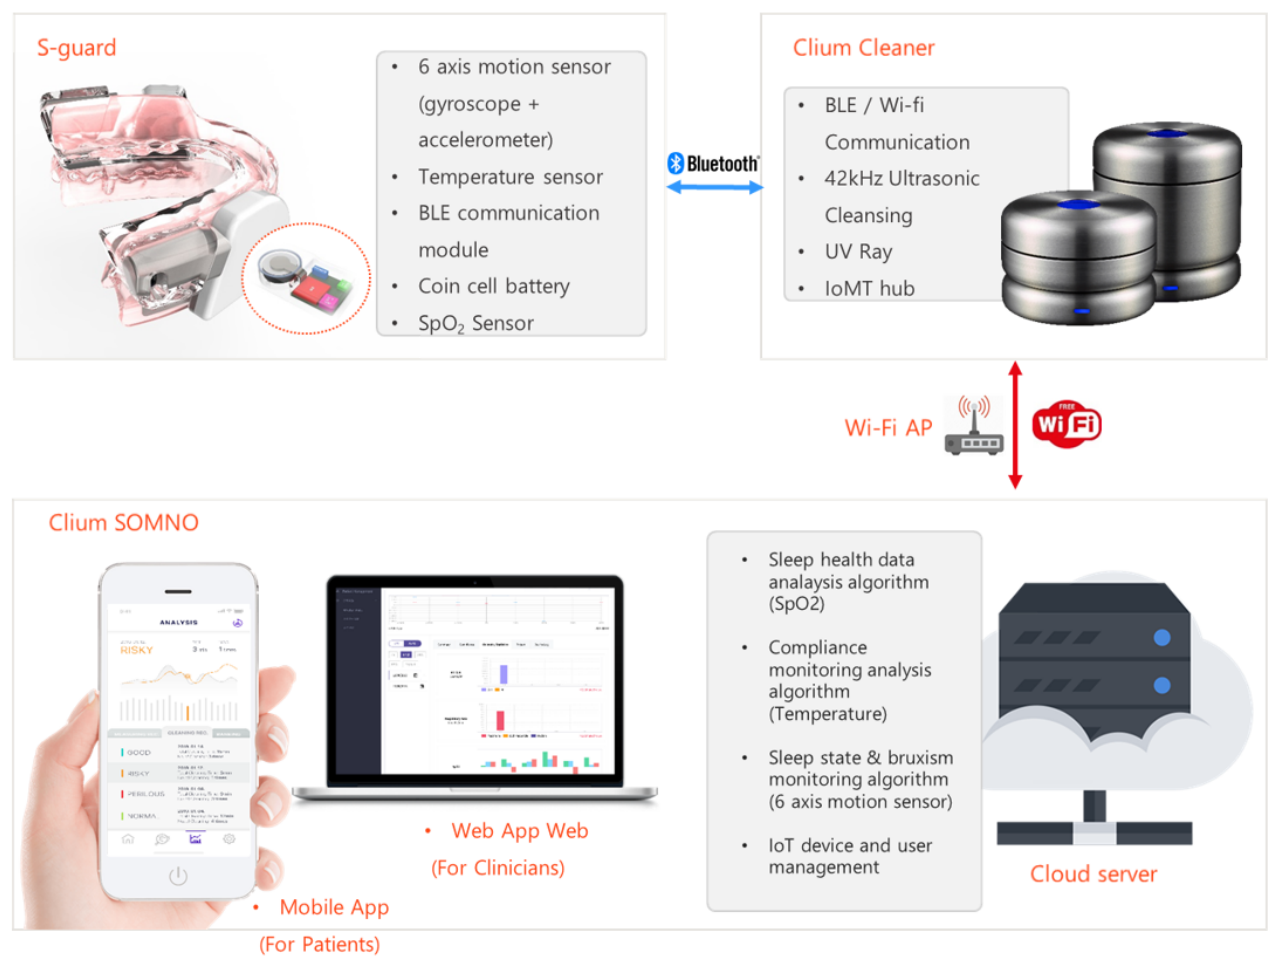
Figure 3. Overall system